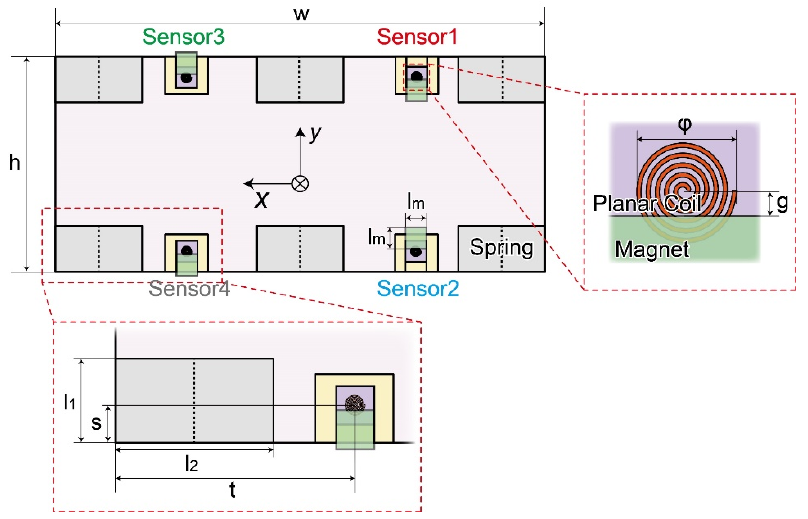
Figure 2. Schematic image of the position and dimension of the force plate components.